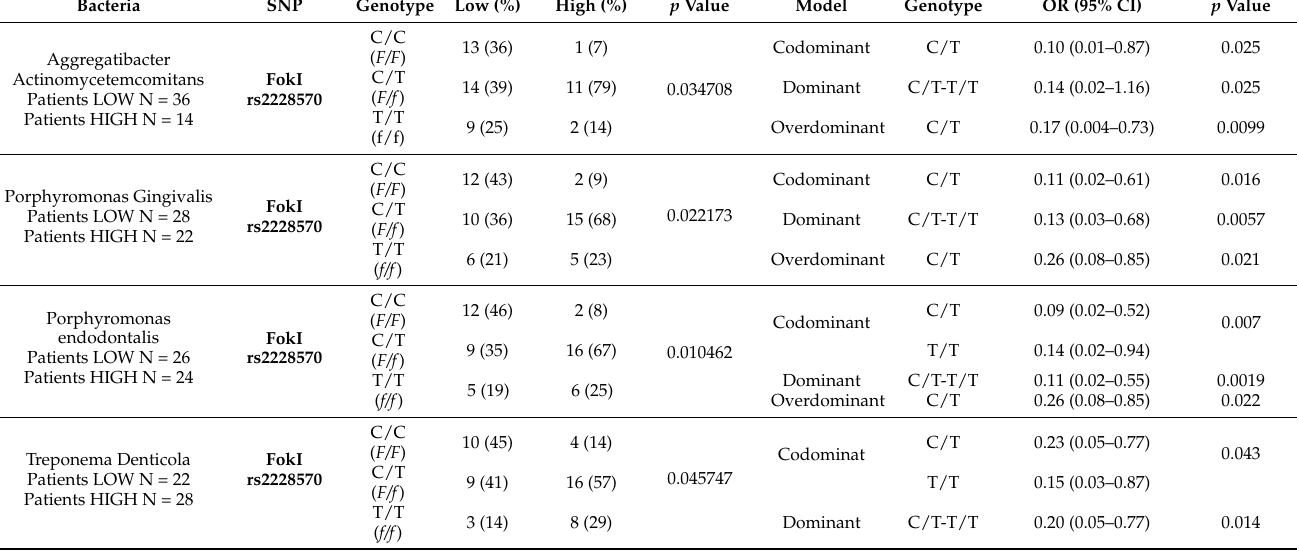
Table 7. Distributions of genotype frequencies of VDR SNPs that had a significant correlation comparing patients with low (LOW) and high (HIGH) levels of bacterial load and corresponding ORs and 95%